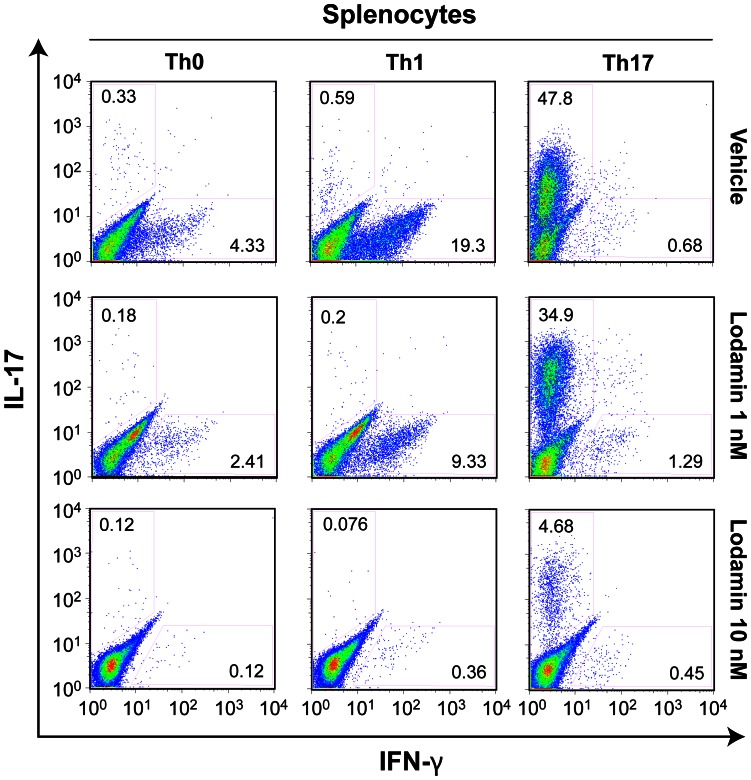
Lodamin inhibits Th1/Th17 cell differentiation.Whole splenocytes were activated by anti-CD3 antibody for 3 days under Th1 or Th17 polarization conditions in the presence or absence of Lodamin (vehicle, 1 nM and 10 nM), followed by stimulation with PMA and ionomycin in the presence of Brefeldin A; Cell were analyzed by FACS following intracellular cytokine staining of IL-17 and IFN-γ, all plots are gated on CD4+ cells. Data are representative of three independent results.